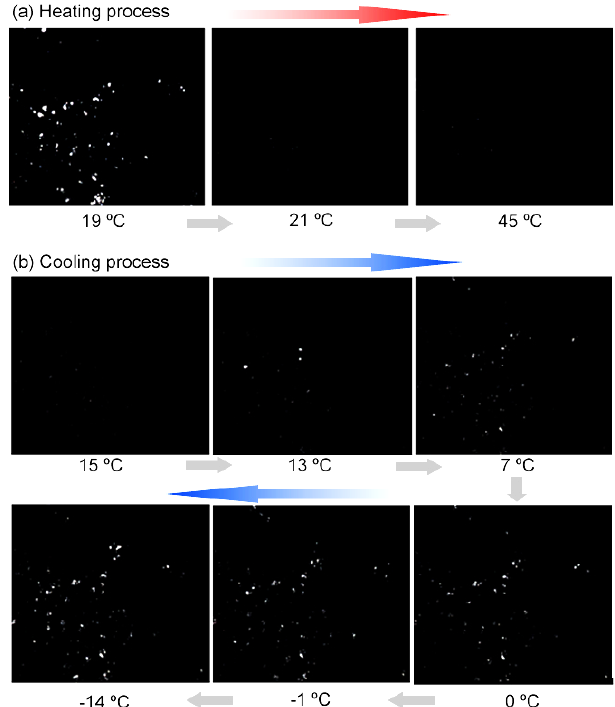
Figure 8. Real-time optical images of the n -hexadecane-encapsulated microcapsules during the heating–cooling under transmission mode of microscope equipped with polarizers.